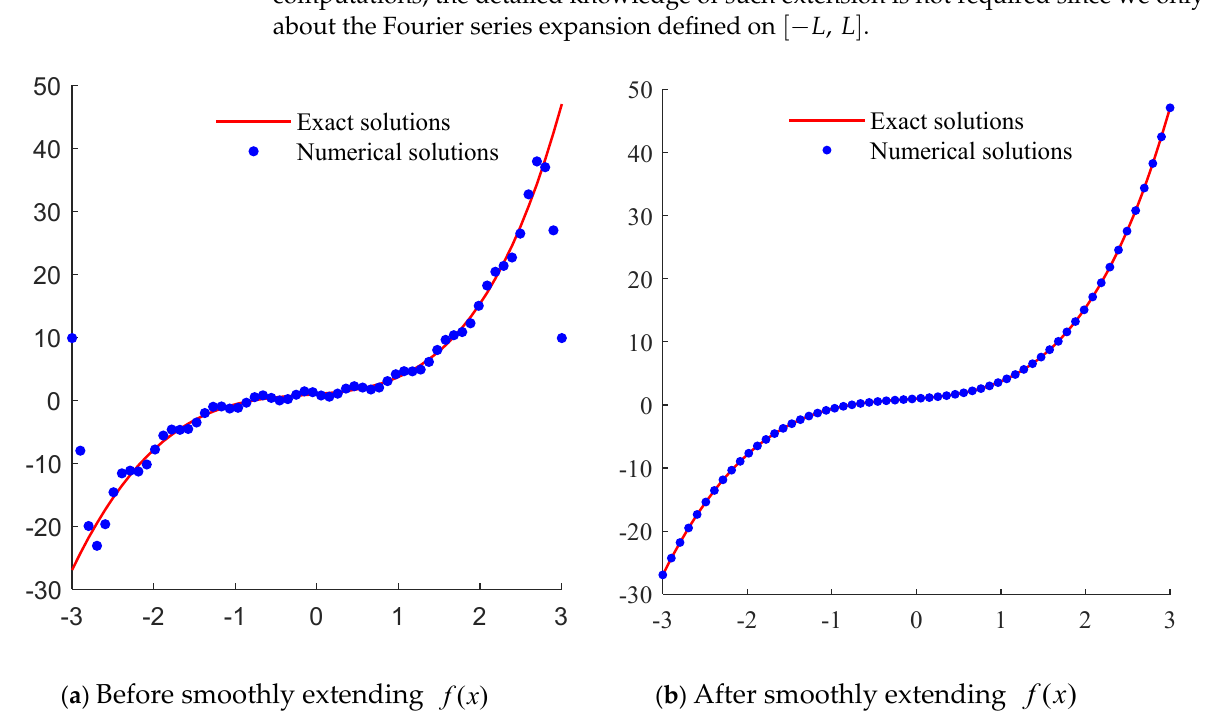
Figure 2. Comparison of the exact and Fourier-series solutions before ( a ) and after ( b ) smoothly extending the original function f ( x ) .